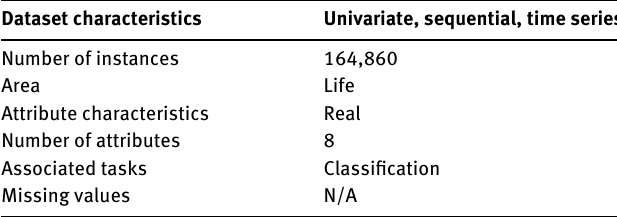
Table 1: Description of Localization Dataset. Dataset